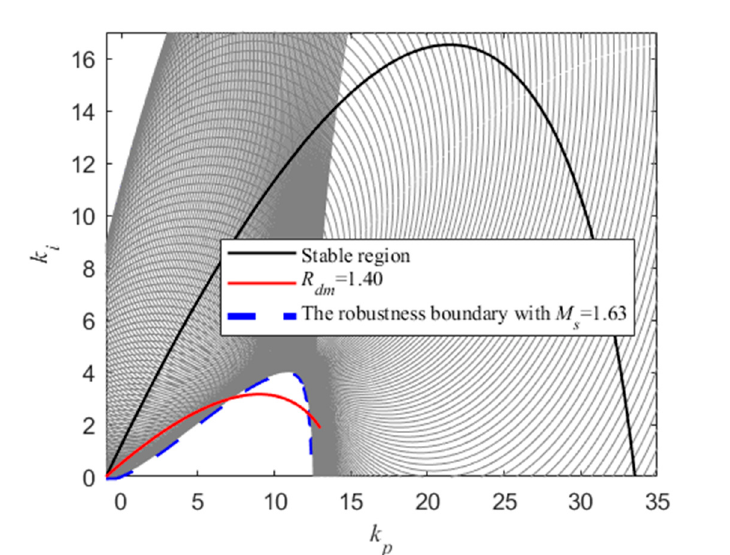
Figure 17. The distribution of k p and k i with k d =